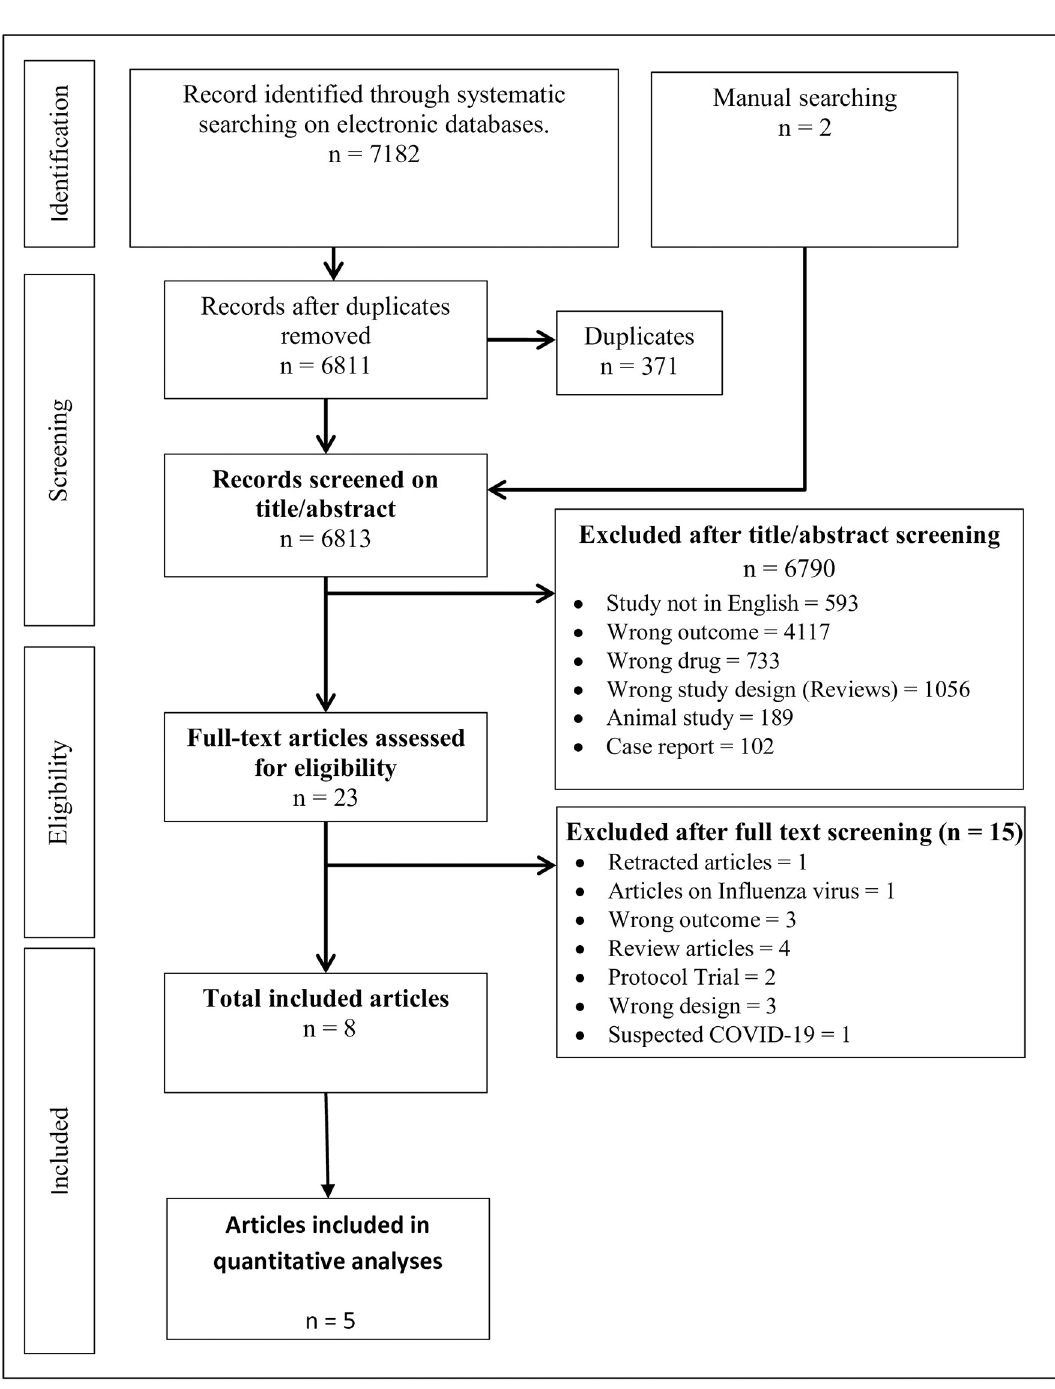
Fig 1. PRISMA flow diagram. Figure shows the entire screening